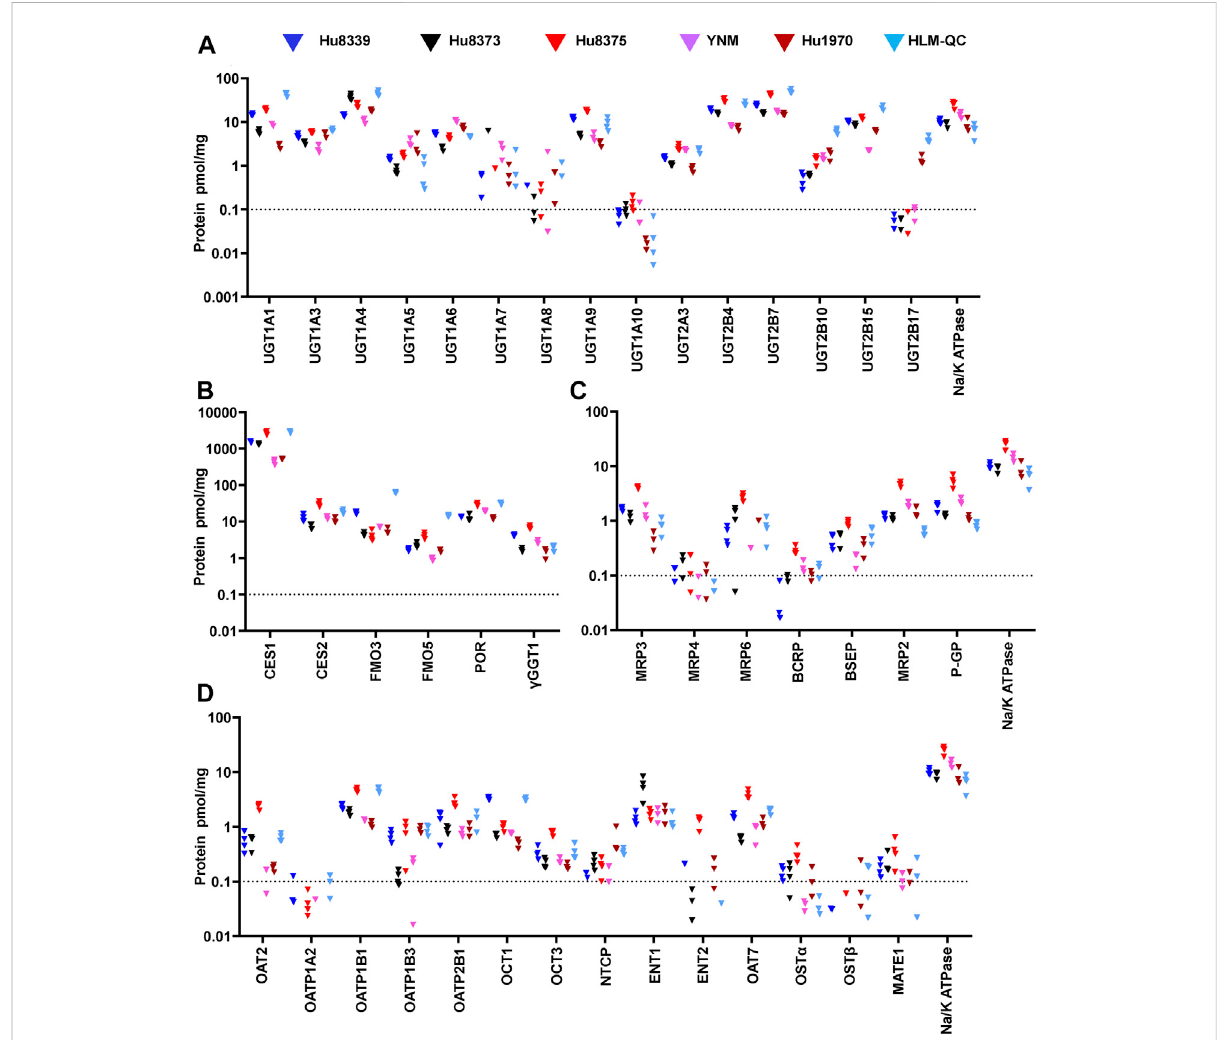
FIGURE 1 Basal absolute protein concentrations of DMEs and transport proteins in SCHH. Absolute concentrations of 15 UGTs (A) , six other DMEs (B) , seven ABC transport proteins (C) , and 14 SLC transport proteins (D) in SCHH. Concentrations of each DME and transport protein, and Na + /K ATPase, werequanti fi edinmembranefractionsisolatedfrom fi vequali fi edhepatocytedonorsunderbasalconditionsandinahumanlivermicrosomequality control(HLM-QC)sample.TheSCHHsamplesincludedthreetofourbiologicalreplicatesineachdonor,andtheHLM-QCsamplewasanalyzed in duplicate. The dotted line at y = 0.1 pmol/mg represents lower limits of quantitation